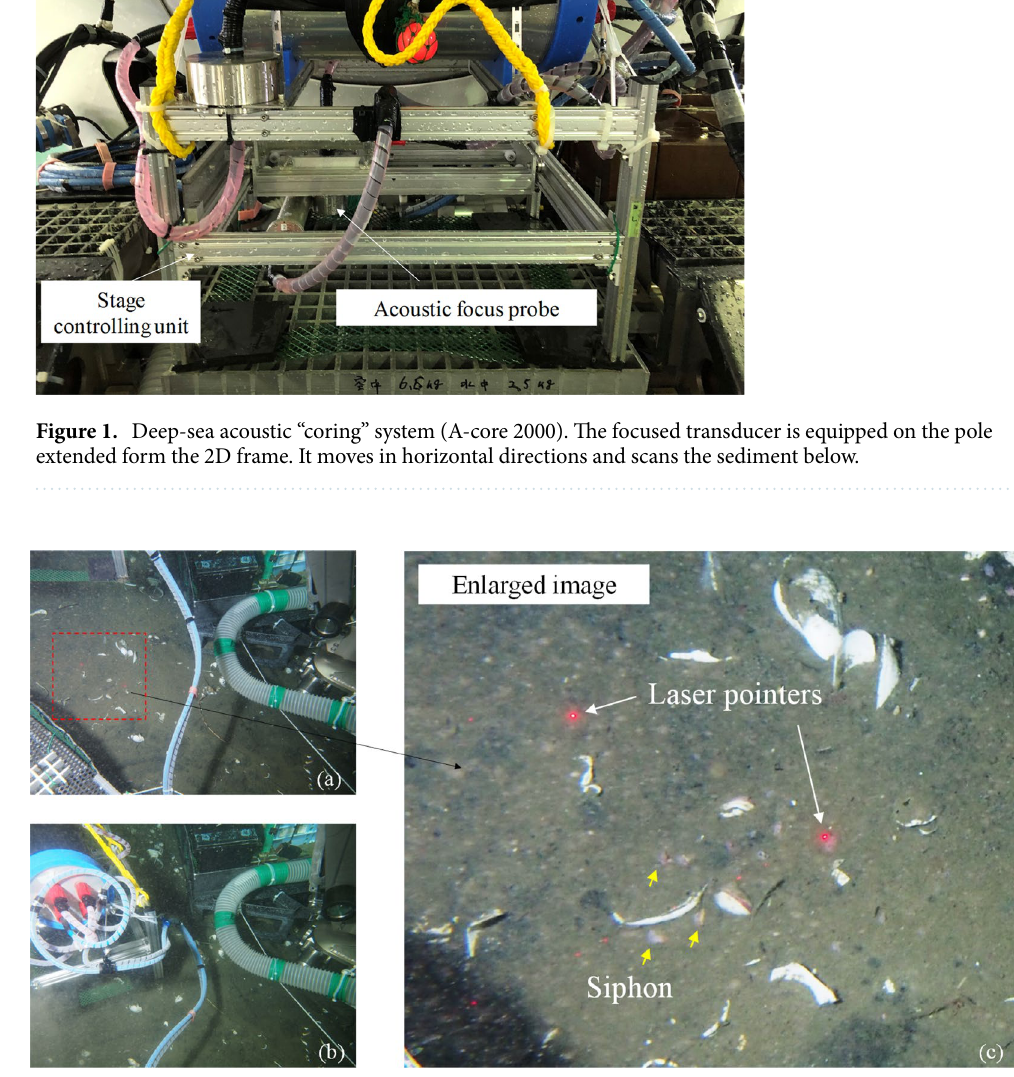
Figure 2. Deployment of the A-core-2000 on the seafloor. Laser pointers were used as markers and the system was gently placed (a → b). Several siphons could be seen on the seafloor surface